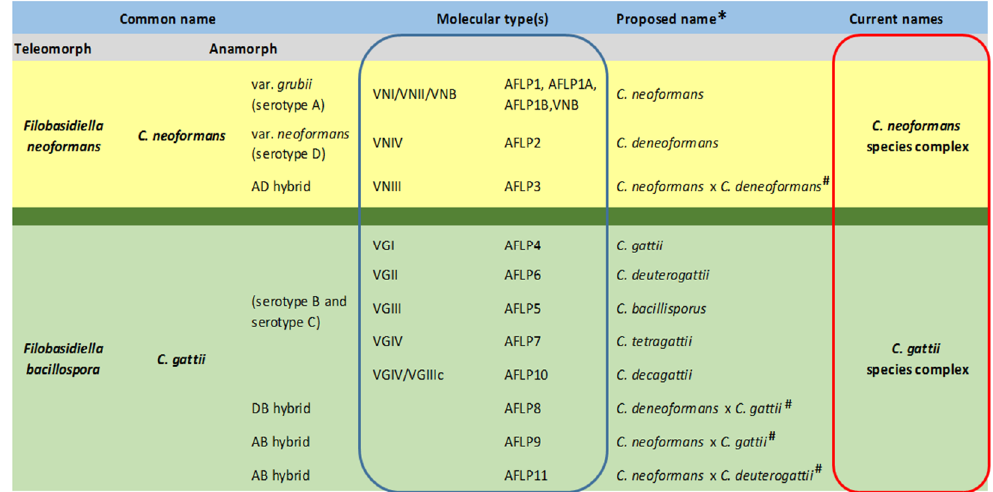
Figure 1. Historical nomenclature of C. neoformans and C. gattii species complex. * Hagen et al., 2015 [18]; # hybrid (Modified from Kwon-Chung et al., 2017 [3]).